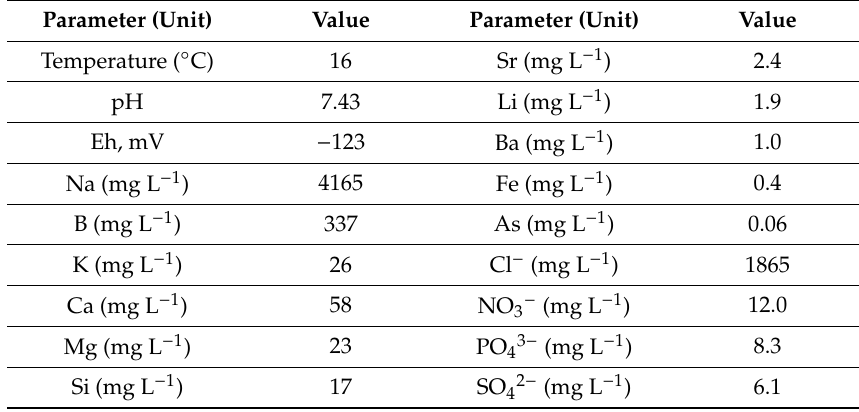
Table 1. Physical and chemical characteristics of the water extracted from the mud sample. Parameter (Unit)